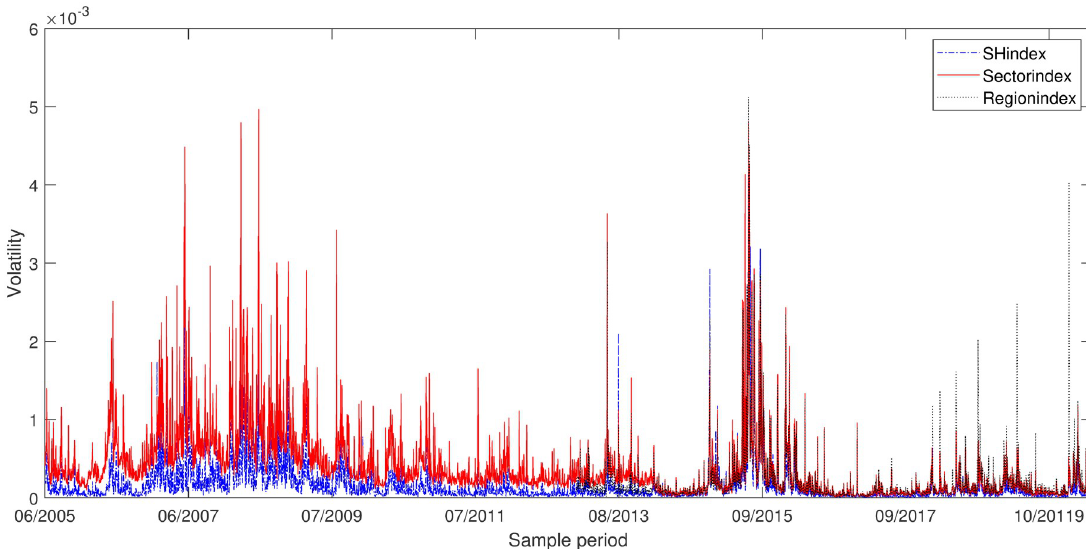
Fig 1. Comparison of volatility. Daily return volatility for Shanghai composite index(red), industry index(blue) and region index(dark).